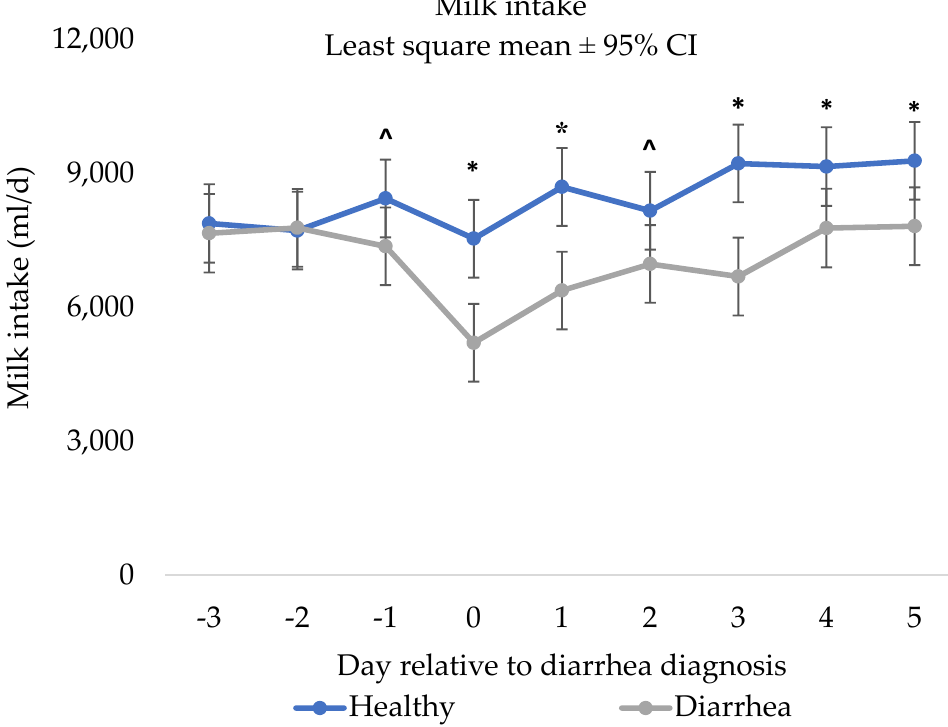
Figure 1. Results of the repeated measures mixed linear regression model assessing the relationship between day relative to neonatal calf diarrhea diagnosis (day 0) and least square mean milk intake (mL/d) of pair matched control ( n = 31) and diarrhea ( n = 31) calves fed by an automated milk feeder, preweaning. A calf was defined as having neonatal calf diarrhea if they had a fecal consistency score of 2 or 3 (runny to watery consistency) for two or more consecutive days. Calves were matched on farm, gender and age and the model included calf and pair number to account for the matched pair analysis. The error bars represent ± 95% confidence interval. * Indicates a significant difference ( p ≤ 0.05), and ^ indicates a tendency (> 0.05 p < 0.10).